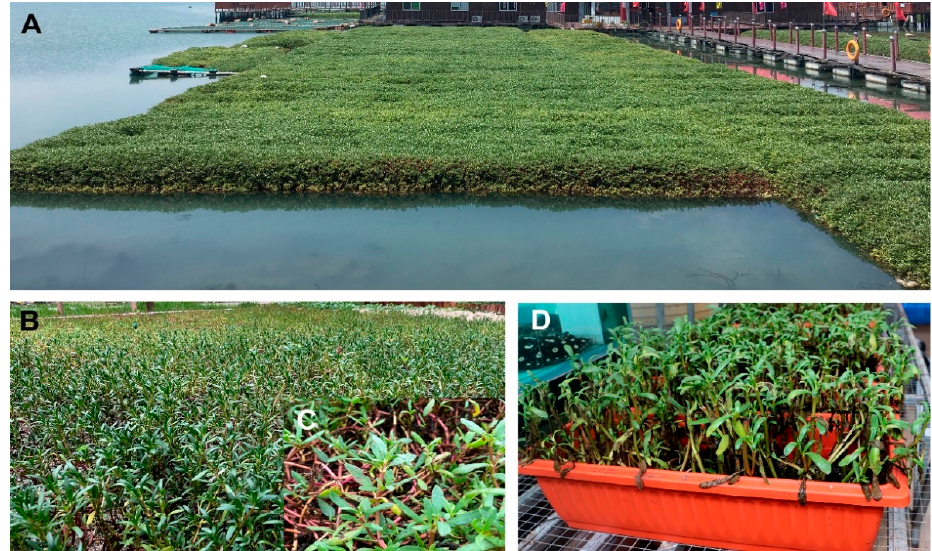
Figure 1. Sesuvium portulacastrum plants were used for remediation of pollutants in aquaculture ( A ) and stabilization of shoreline soil ( B ) in Fujian, China. The occurrence of disease caused by Gibbago trianthemae in S. portulacastrum grown in coastal soil ( C ) and during cutting propagation ( D ). All the photos were taken by Xiangying Wei.